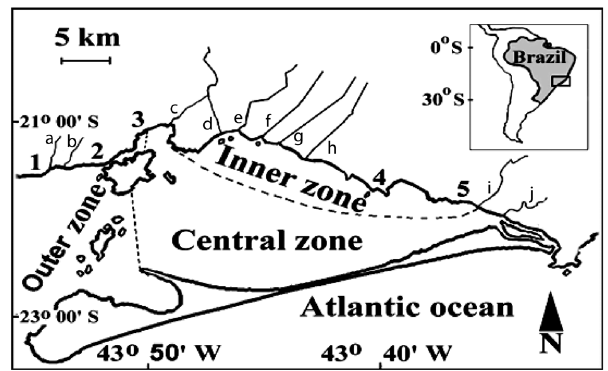
Fig. 1. Study area, Sepetiba Bay, Brazil, with indication of the beach seine sampling sites (1-5). a - rio Prata; b - rio Corumbi; c - rio Cação; d - rio Mazomba; e - rio Guarda; f - canal São Francisco; g - canal Guandu; h - canal Itá; i - rio Piraquê; j - rio